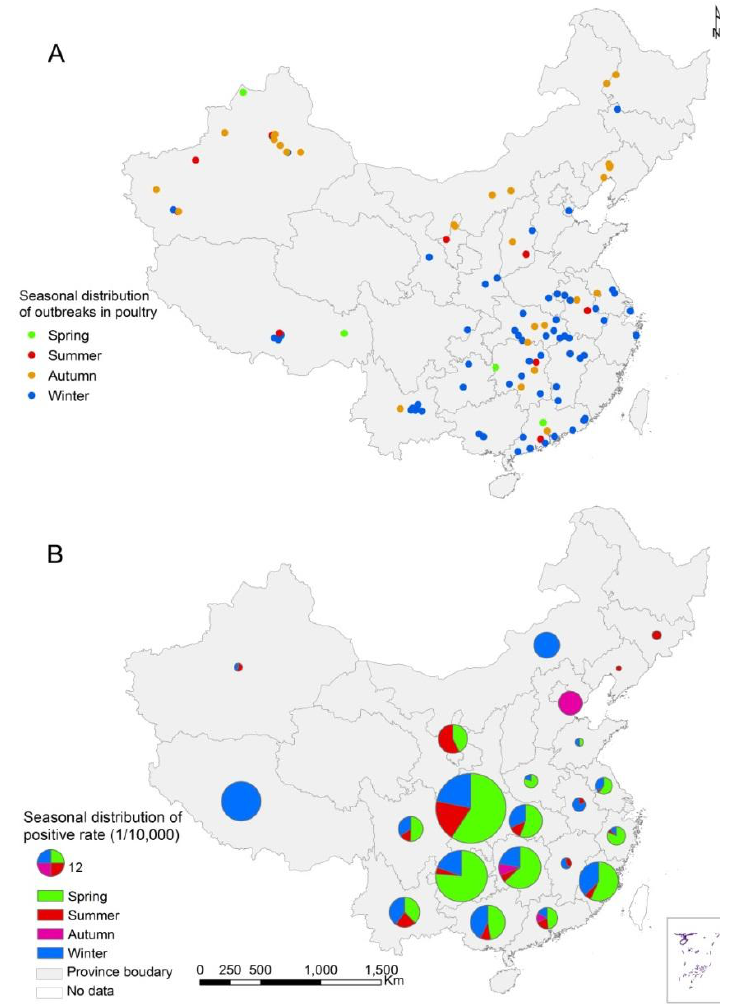
Figure 3. Seasonal distribution of HPAI H5N1 outbreaks and positive samples at province-level; ( A ) Seasonal distribution of HPAI H5N1 outbreaks in domestic poultry, 2004–2012; ( B ) Seasonal distribution of positive rate in surveillance, 2006–2012. In the multivariate analysis, five variables including vaccination rate, interaction between distance to the nearest city and national highway, interaction between distance to the nearest lake and wetland, and density of human population, as well as the autoregressive term were found to be independent risk factors in the occurrence of HPAI H5N1 outbreaks (Table 2). The ORs for the vaccination rate, interaction between distance to the nearest city and national highway, and interaction between distance to the nearest lake and wetland were 0.79 ( p value < 0.001), 0.96 ( p value = 0.002) and 0.87 ( p value < 0.001) respectively. HPAI H5N1 outbreak was also influenced by density of human population (OR = 1.44, p < 0.001) and the autoregressive term (OR = 1.40, p value <